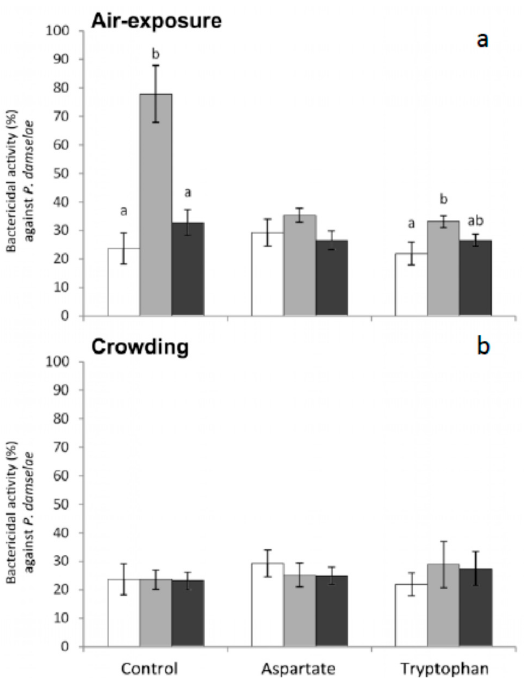
Figure 7. Bactericidal activity (%) against P. damselae in fish stressed by ( a ) air-exposure or ( b ) crowding. Results are shown as mean ± standard error. Different letters indicate significant differences among non-stressed fish (white bars), 1 h post stress (grey bars) and 6 h post stress (black bars). Differences were considered significant when p < 0.05.